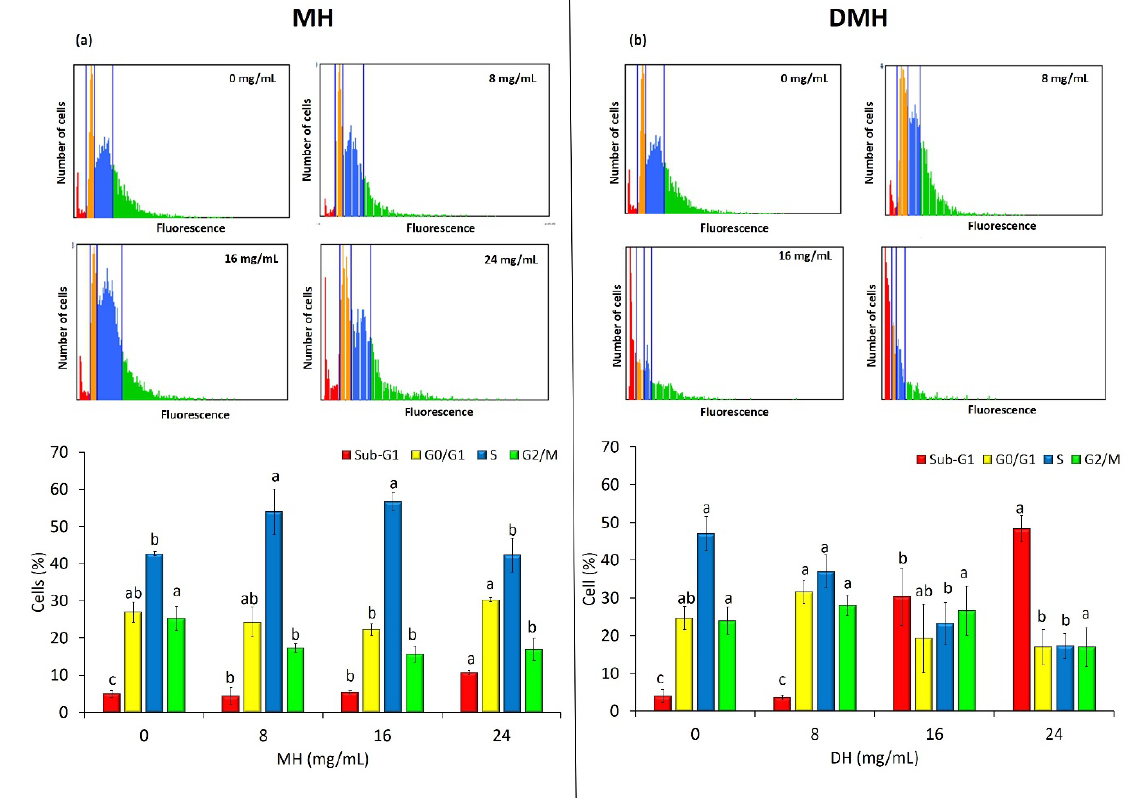
Figure 6. MH ( a ) and DMH ( b ) induce cell cycle arrest in HCT-116 cells. The cells were treated with different concentrations (0, 8, 16 and 24 mg/mL) of MH or DMH for 48 h. The percentages of cells in Sub-G1 (red; apoptotic cells), G0/G1 (yellow), S (blue) and G2/M (green) were calculated by Tali ® Image-Based Cytometer. The fluorescence images are representative of the effect of MH and DMH in the cell cycle of HCT-116. Values are expressed as the mean of three independent experiment ± SD. The different superscript letters (a–c) in each bar indicate significant difference ( p < 0.05).